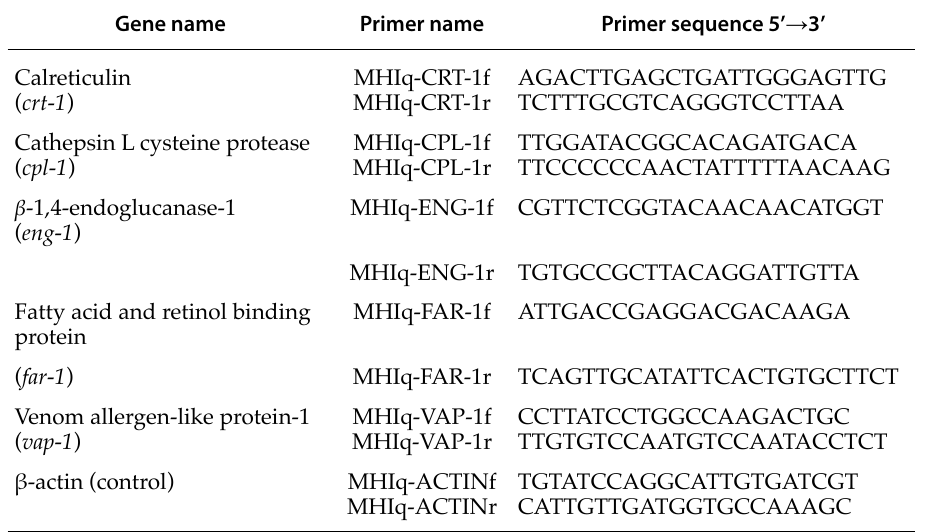
Table 1. Meloidogyne hispanica (MHI) primers used in qRT-PCR for amplification of several candidate parasitism genes, with β-actin as